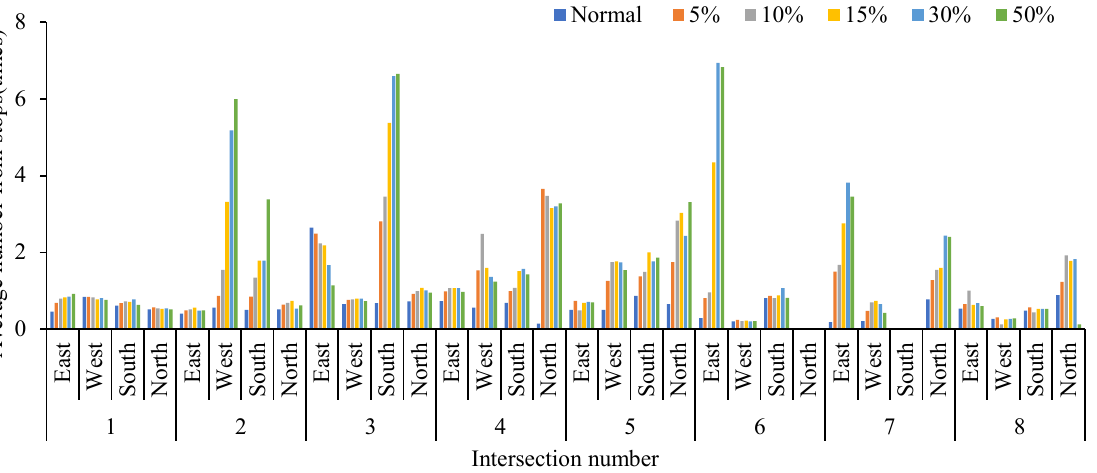
Figure 9. Comparison of average number form stops at different intersections.